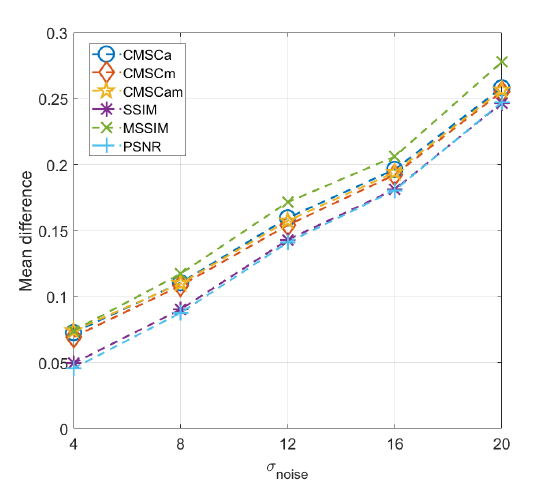
Figure 3. Average values of the absolute difference of parameters found by no-reference mutual information metrics and by full-reference metrics on BSD database A result of dermatological immunofluorescence microscopy